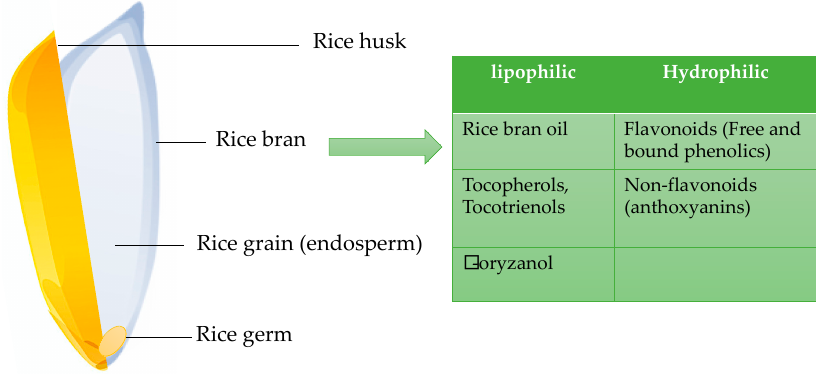
Figure 3. The phytochemical components of whole grain rice.